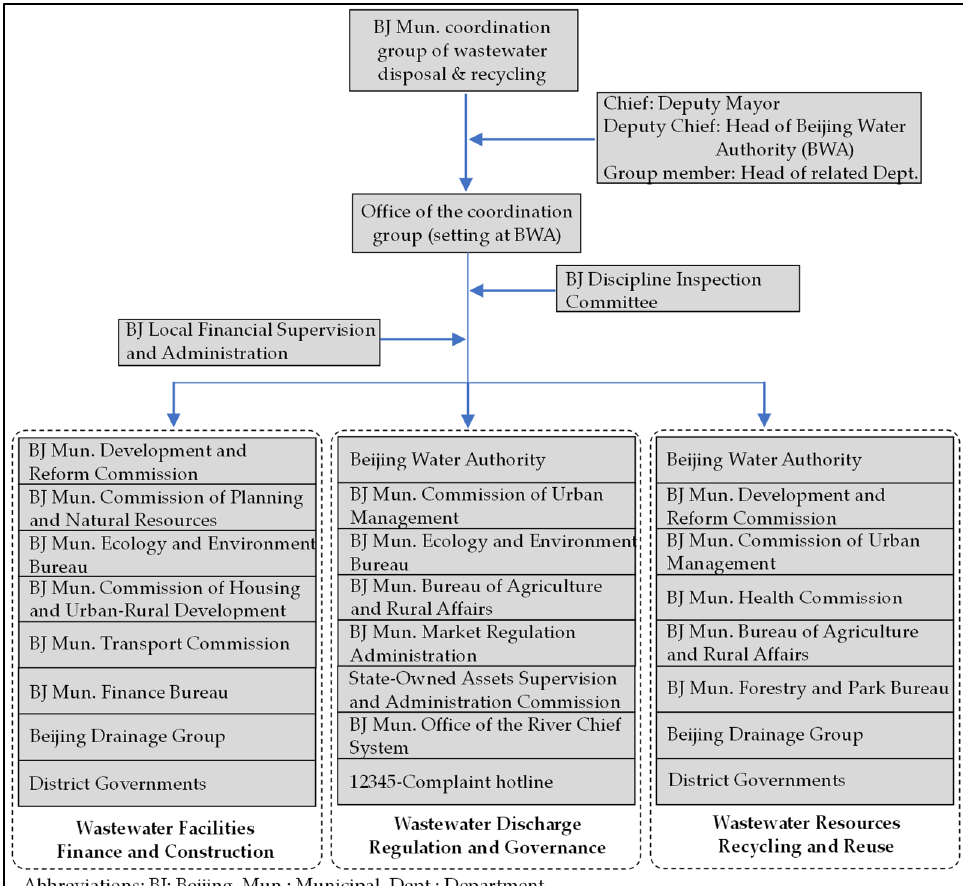
Figure 4. The structure of the coordination group for wastewater treatment and reuse in Beijing.